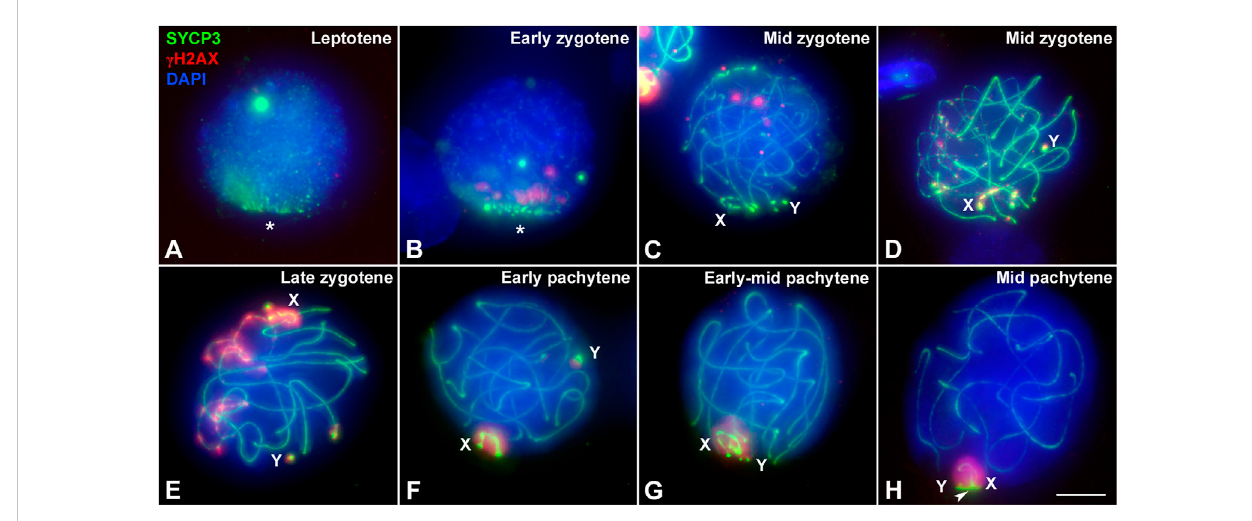
FIGURE 5 Localization of DNA damage in Thylamys elegans spermatocytes preserving the 3-dimensional topology of chromosomes. Squashed spermatocytes labeledwith antibodies againstSYCP3(green)and γ H2AX(red)and DAPI(blue). (A) .Leptotene.No γ H2AXlabelingisobserved. AEs appear polarized in a bouquet con fi guration (asterisk). (B) . Early zygotene. A few small γ H2AX signals are observed at the region where synapsis is initiating. The bouquet polarization is still evident. (C) . Mid zygotene. Synapsis has progressed. A few γ H2AX foci are scattered within the nucleus. (D) . Mid zygotene. γ H2AX labeling starts to be observed at the unsynapsed regions of autosomes and sex chromosomes (X, Y). (E) . Late zygotene. γ H2AX signal increases on unsynapsed chromosomes. Sex chromosomes are detected at opposite nuclear spaces and the γ H2AX labeling extends from their AEs to the surrounding chromatin. (F) . Early pachytene. γ H2AX is only detected on the chromatin of sex chromosomes, clearly separated in the nucleus. (G) . Early-mid pachytene. Sex chromosomes approach and associate to each other. (H) . Mid pachytene. Sex chromosomes pair and form the dense plate (arrowhead). γ H2AX labels the whole sex body. Bar: 5 μ